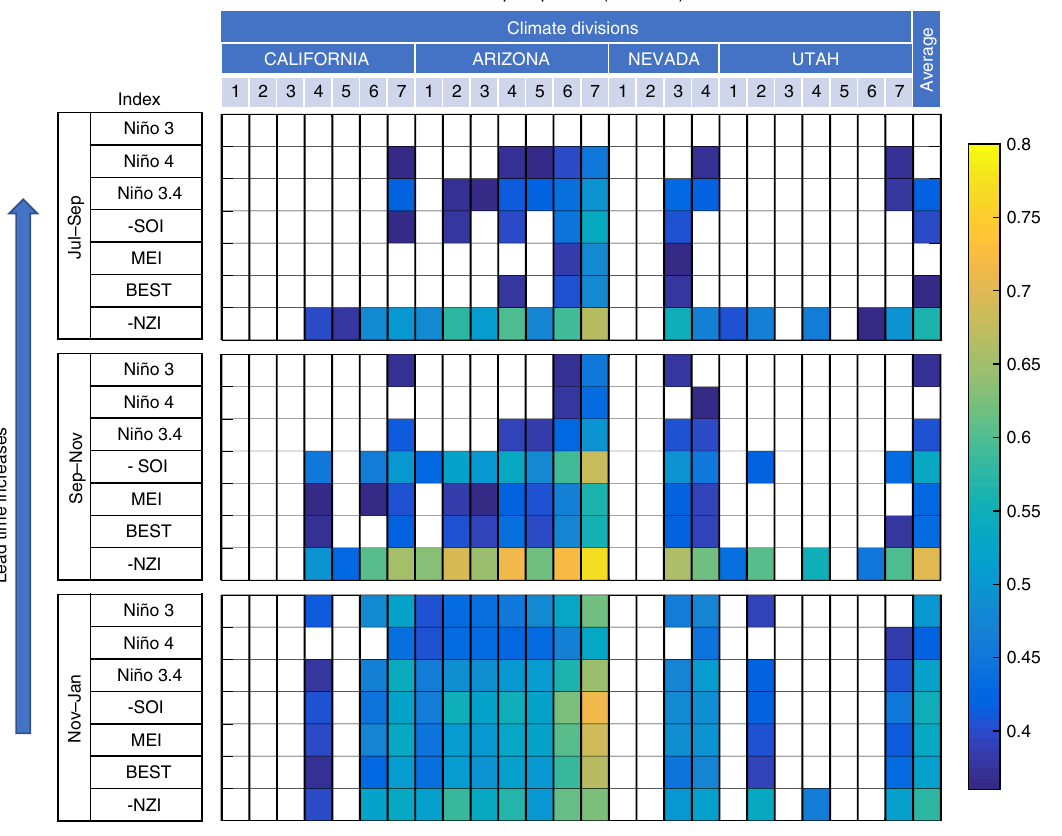
Fig. 3 Comparison of ENSO and NZI teleconnection strengths. Colors illustrate correlation values between precipitation in different climate divisions over SWUS (Nov – Mar) and selected climatological indices corresponding to different 3-month periods, for 1982 – 2015. Colors denote statistically signi fi cant correlations ( α = 0.05 signi fi cance level). Results in the last column were calculated using the regionally averaged precipitation amount. NZI outperformed existing indices (correlation of − 0.7 compared to 0.3 – 0.5) and provided statistically signi fi cant predictions with a 3-month lead time. Multivariate ENSO Index 5 (MEI) and Bivariate ENSO Timeseries 59 (BEST) are comprehensive indices consisting of multiple meteorological variables (SST, sea level pressure, surface wind, etc.) for determining ENSO